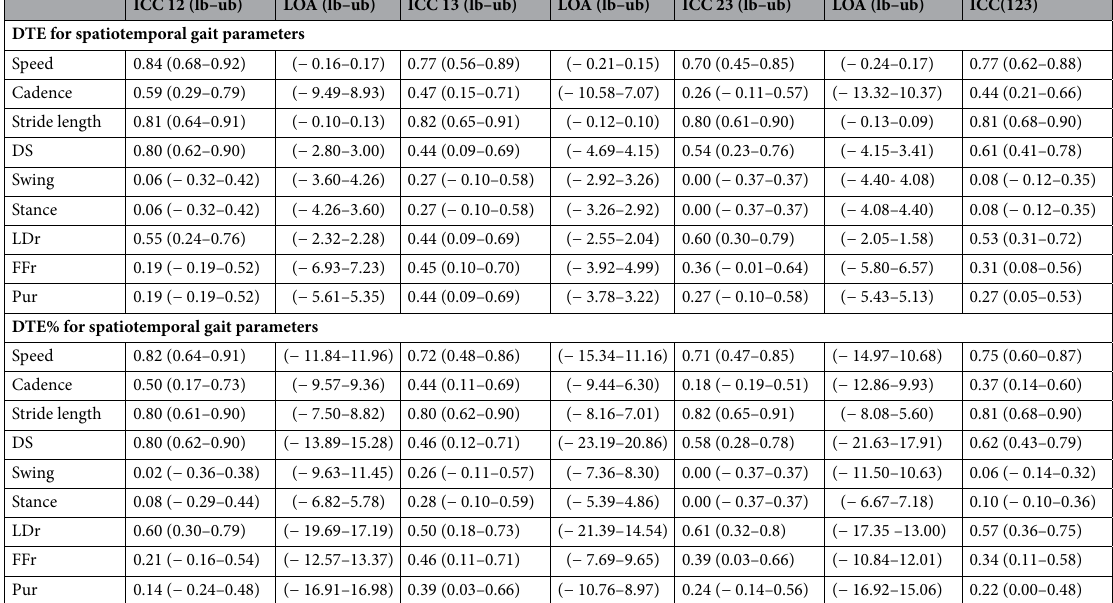
Table 6. Intraclass correlation coefficients (ICC) and limits of agreement (LOA) values for dual task effects (DTE) and DTE percentage of gait parameters. Abbreviations: DTE = dual task effects, DS = double support, LDr = Load Ratio, FFr = Foot flat ratio, Pur = Push